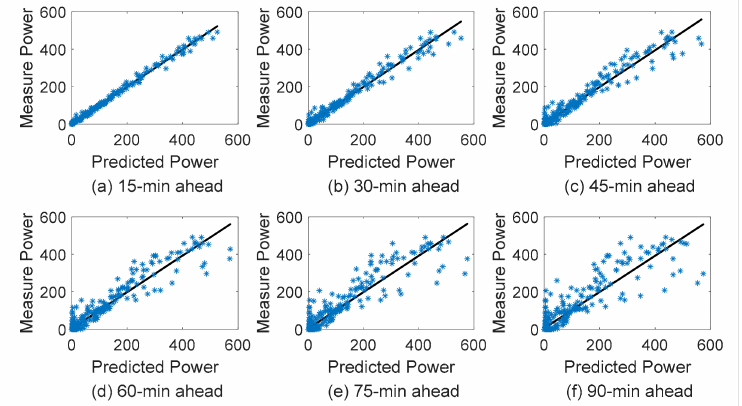
Figure 9. ( a – f ). The results of the linear regression for the predicted and measured power in case